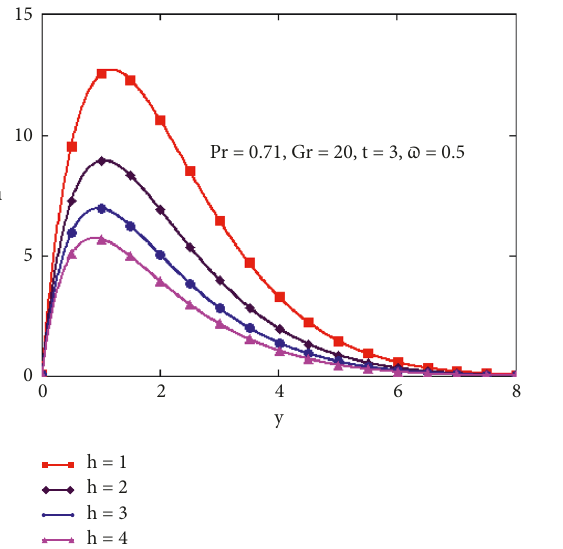
Figure 2: Velocity profile for different values of h .